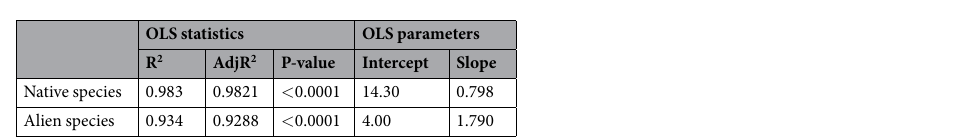
Table 2. Results of the ordinary least squares regression (OLS) for the number of species recorded on each island in the 1951–2015 period regressed on the number of species recorded on the same islands in the 1830– 1950 period (n = 16).